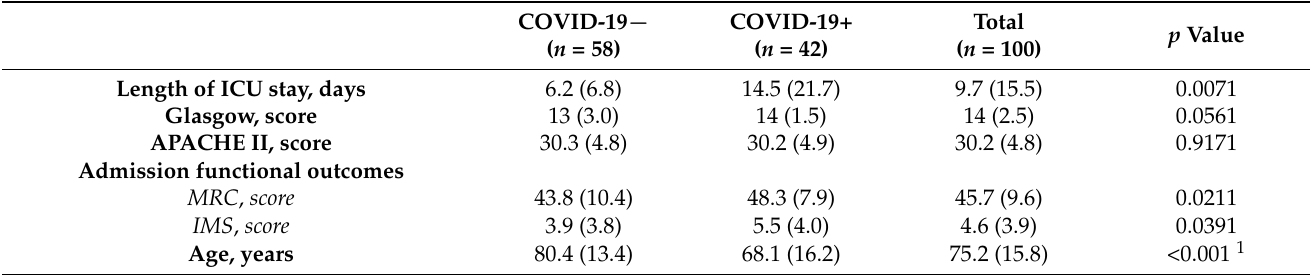
Table 1. Summary and comparison of demographic data of inpatients with cardiovascular disease hospitalized with or without COVID-19 ( n =